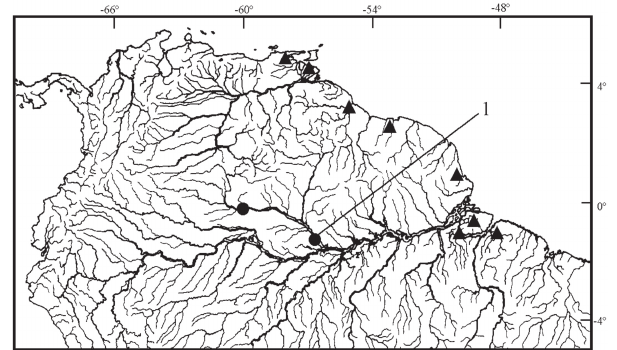
Fig. 4. Map of north of South America. Black circles are collection sites of Polycentrus jundia , new species; 1= type locality. Black triangles are distribution of Polycentrus schomburgkii . Some points may represent more than one